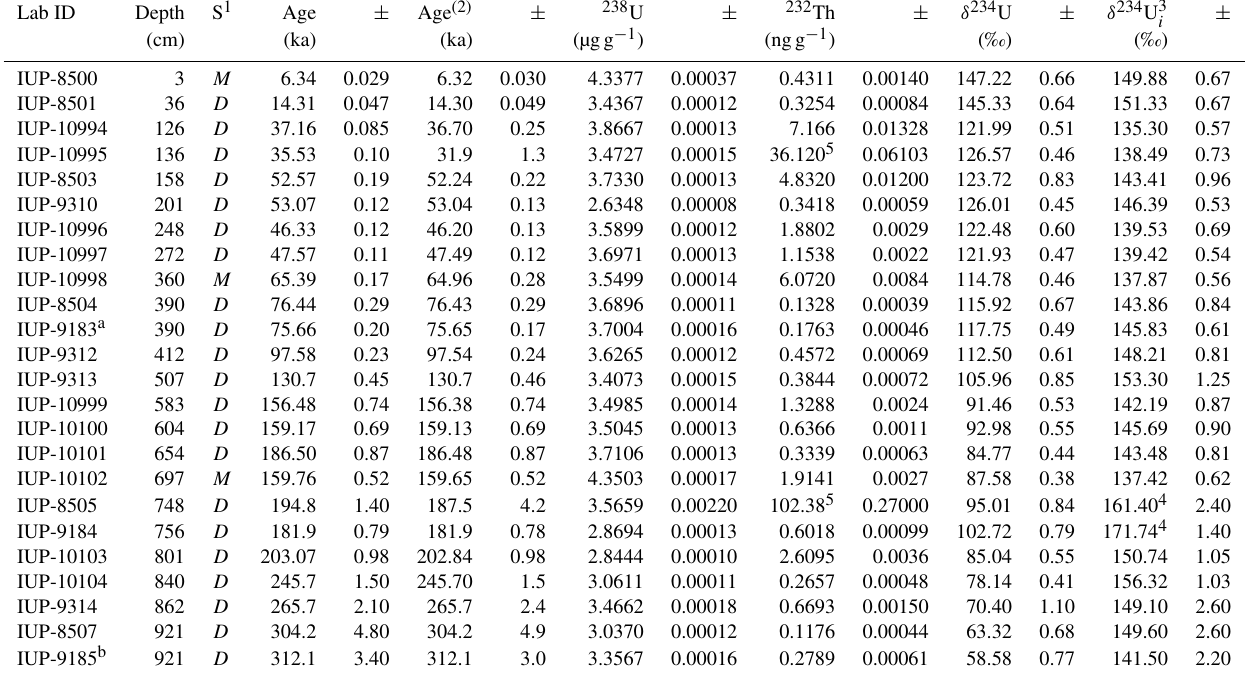
Table 2. Uranium-series isotope measurements (U / Th) carried out on 24 coral fragments. All errors are 2 σ of the mean analytical uncer- tainty. Ratios were determined using a Th–U spike calibrated to a secular equilibrium reference material (HU-1 at the IUP). Uncorrected, closed-system age was calculated using the decay constants of Jaffey et al. (1971) for 238 U and Cheng et al. (2000) for 230 Th and 234 U. Ages are reported relative to the date of analysis from the year 2017 (IUP-8500 to IUP-8507) and the year 2018 (other samples), and they do not include uncertainties associated with decay constants. 1 Coral species: M : Madrepora oculata ; D : Desmophylum pertusum . 2 Ages corrected for the contribution of initial 230 Th based on an estimated seawater ( 230 Th / 232 Th) activity ratio of 8 ± 4. 3 Typical δ 234 U i re- constructed from corals for the past 30kyr range between 135 and 155 (Chen et al., 2016). 4 Compared to the present-day seawater value of 146.8 ± 0.1‰, possibly indicative of U-series open-system behaviour. 5 Samples containing strong residual amounts of non-carbonate contamination, leading to high 232 Th concentrations and thus age corrections. a Replicate of IUP-8504; b replicate of IUP-8507.